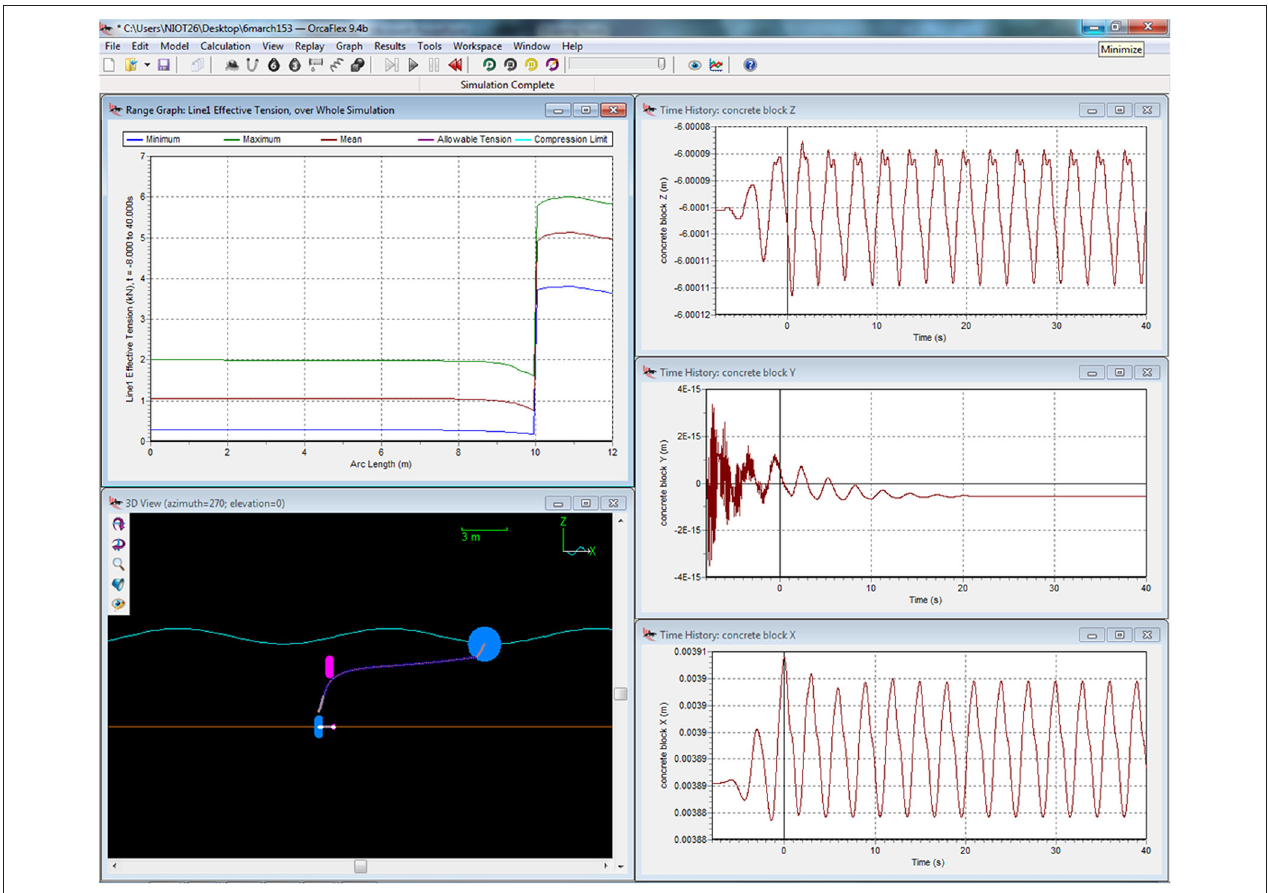
FIGURE 9 | Mooring load